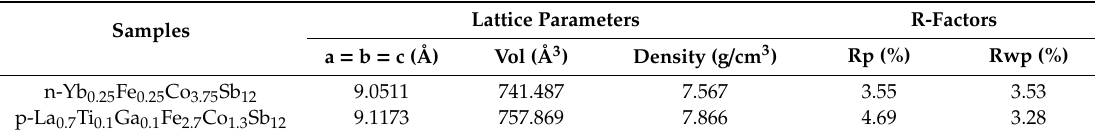
Table 1. Results of the Rietveld refinement analysis.